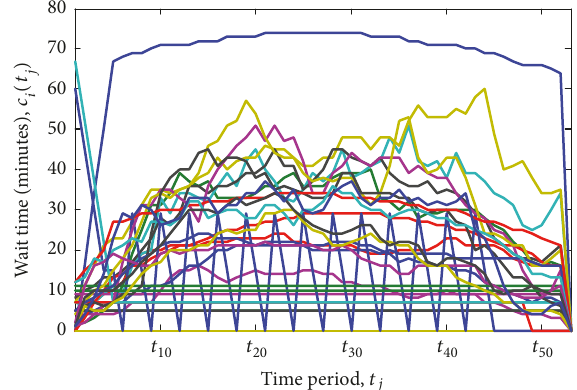
Figure 6: Wait times for 29 attractions at the Magic Kingdom